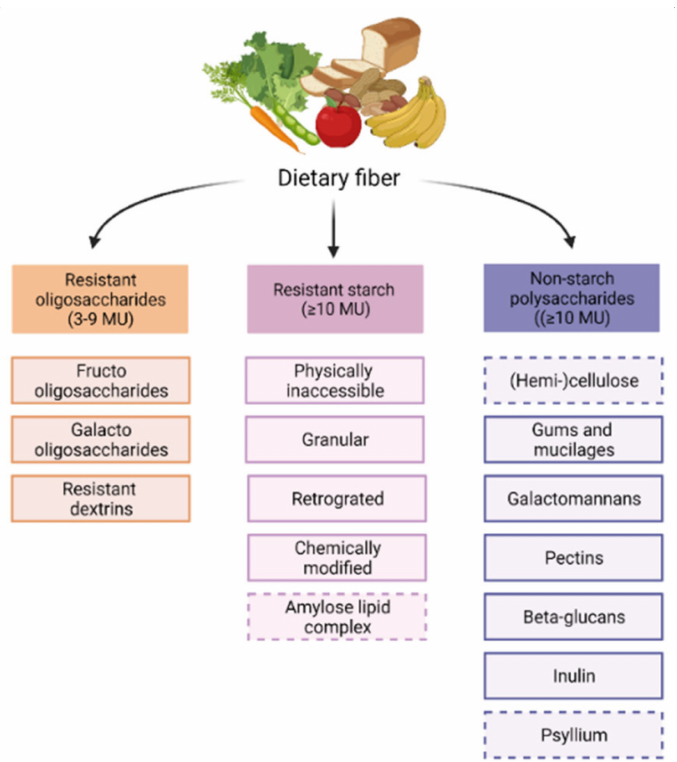
Figure 1. Chemically based dietary fiber classification. Dietary fibers are found in fruits, vegetables, whole grains, legumes, and nuts and seeds. There are three groups in which fibers are chemically classified: Resistant oligosaccharides have 3–9 monomeric units. Resistant starches, and non-starch polysaccharides, have 10 or more monomeric units. Dashed boxes are non-fermentable